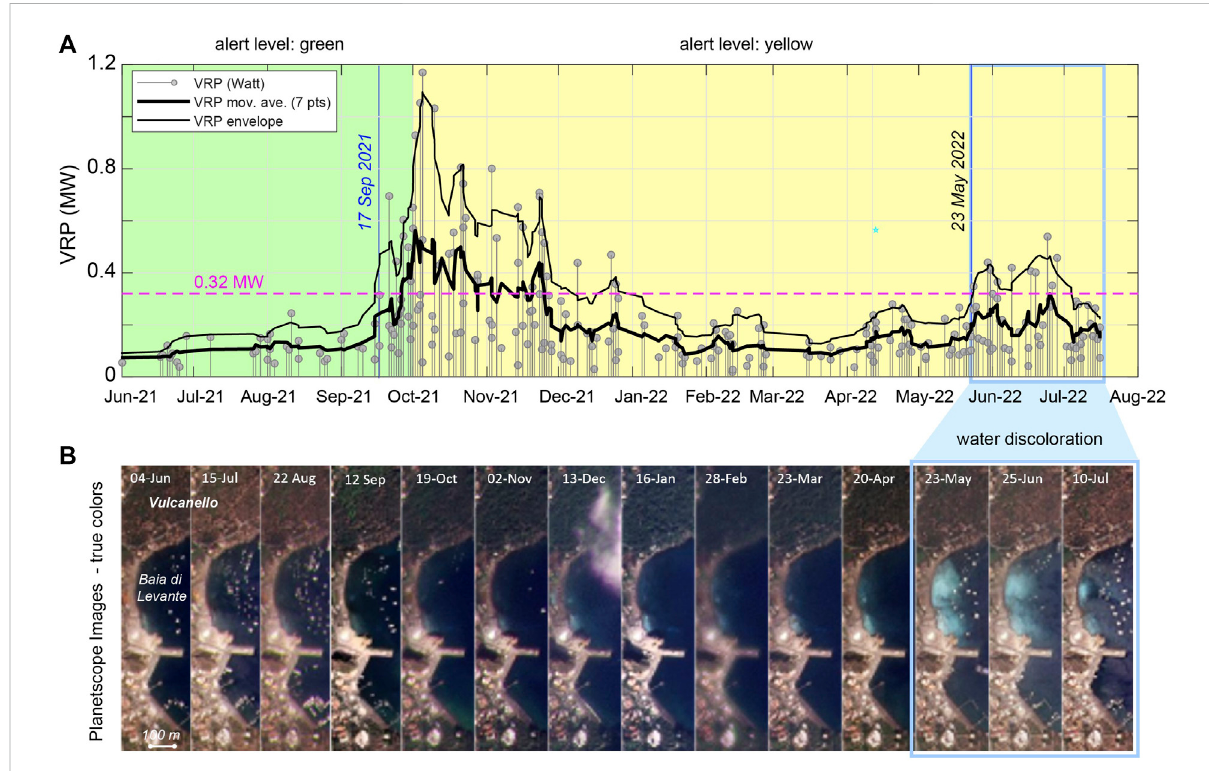
FIGURE 4 Timeseries of (A) VRP (gray stems) recorded between June 2021 and July 2022. The horizontal dashed line de fi nes the statistical threshold of VRP (~0.3 MW) separating the background from anomaly values. This threshold was overpassed continuously between 17 September and 20 December 2021, in concomitance with the main escalation phase of thermal and degassing unrest. Renewed increase of VRP occurred in May 2022 leading to overpass the threshold on 24 May. (B) One year-long selection of natural color images acquired by the PlanetScope satellites over the Baia di Levante (Image credits: Planet Team, 2017). During May-July 2022, in concomitance with the second thermal pulse recorded in the crater area, the Baia di Levante experienced a period of water discoloration (turned milky white) associated to underwater degassing (INGV weekly Report